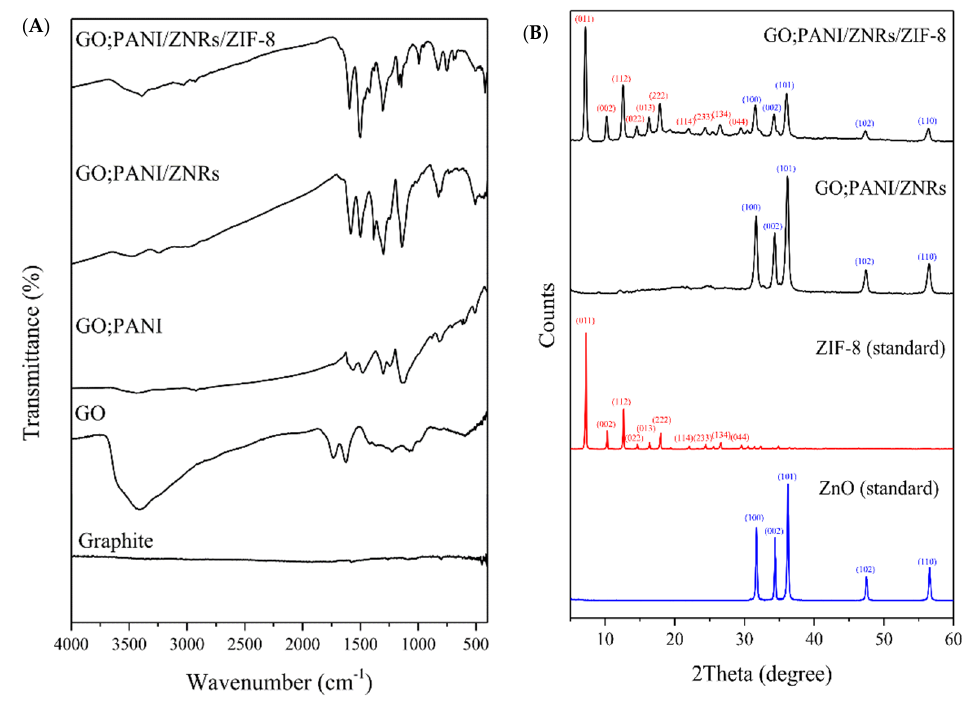
Figure 4. ( A ) FT-IR spectrums of graphite, GO, GO:PANI, GO:PANI/ZNRs, and GO:PANI/ZNRs/ZIF − 8 and ( B ) XRD spectrums of the ZnO (standard), ZIF − 8 (standard), GO:PANI/ZNRs/ZIF − 8, and GO:PANI/ZNRs/ZIF − 8.